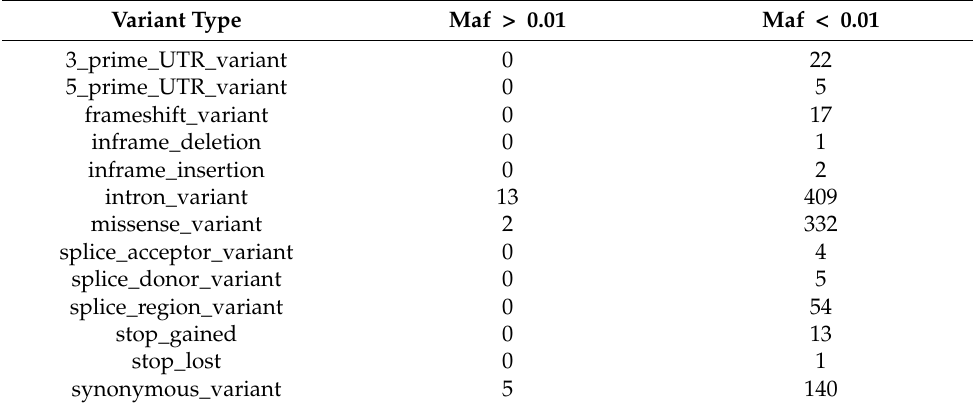
Table 1. Single nucleotide variant (SNV) and INDEL variant in the TMPRSS2